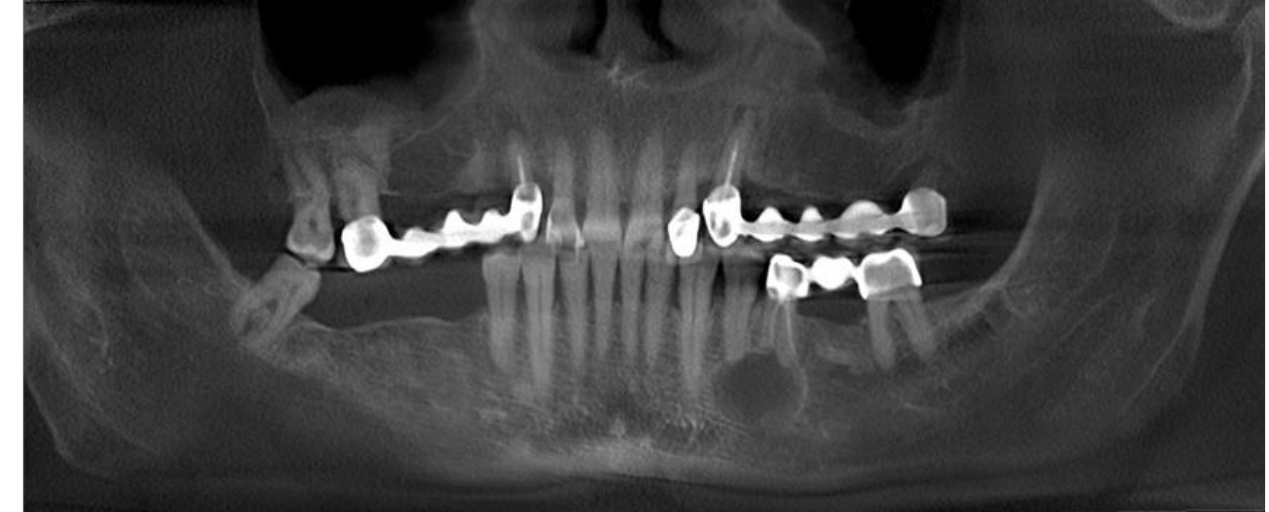
Figure 2. CBCT (cone-beam computed tomography)with clearly visible cyst in the 34/35 area and close proximity of the inferior alveolar nerve.